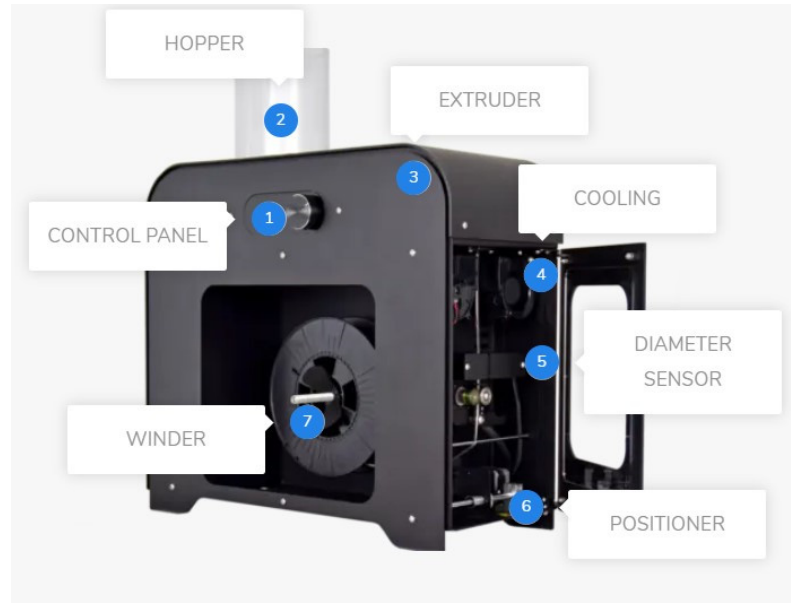
Figure 2. Filament Maker—Composer 450